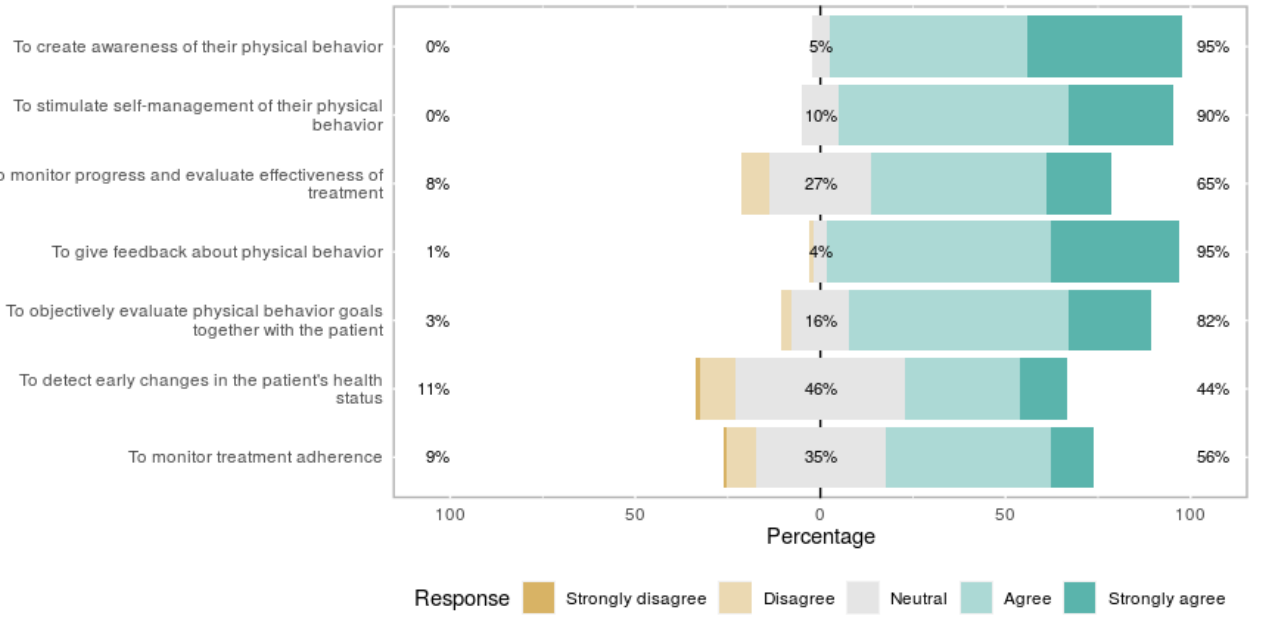
Figure 3. Perceived usefulness for eight different activity monitor